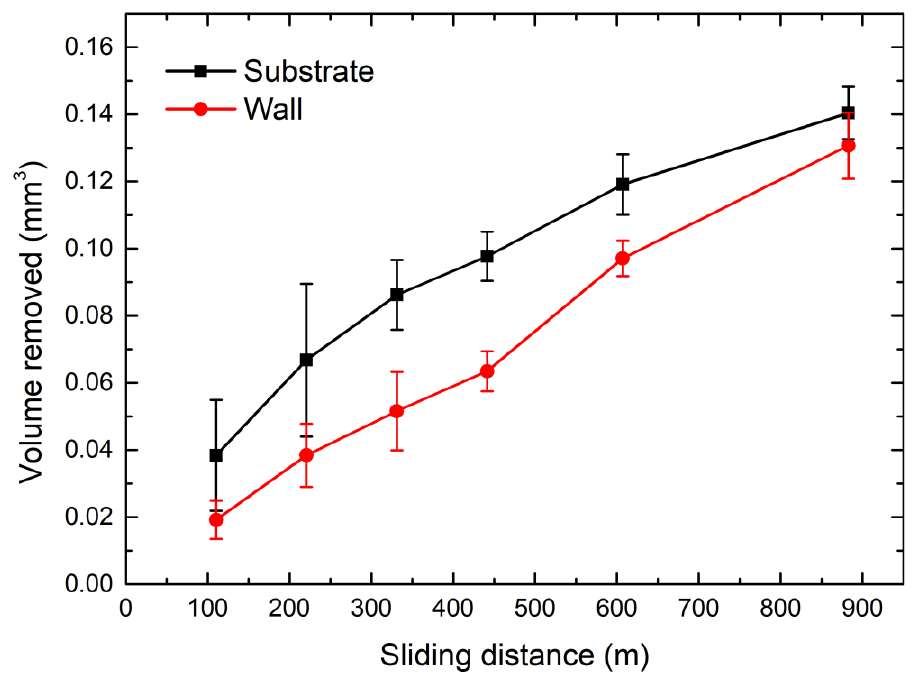
Figure 7: Micro-adhesive wear graphics obtained for the substrate wall